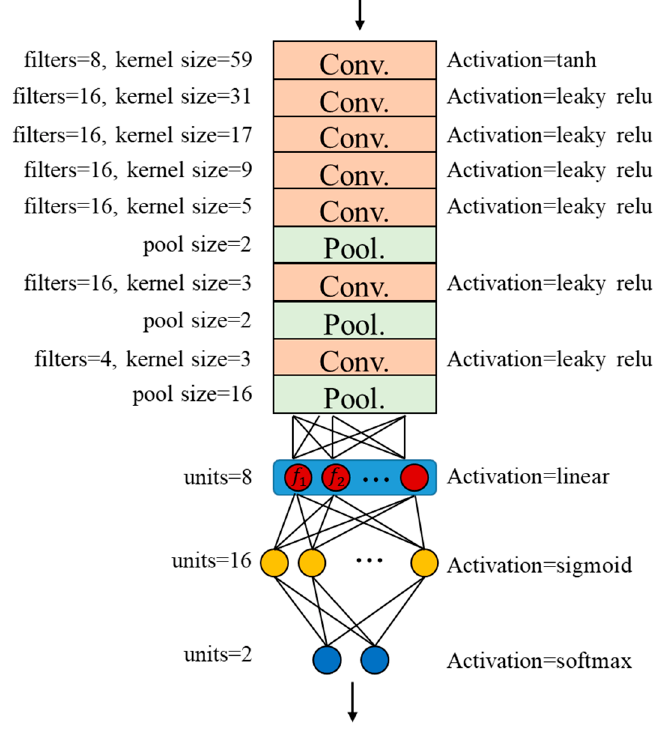
Figure 15. The detailed structure designed. Table 5. The training algorithm and parameters.